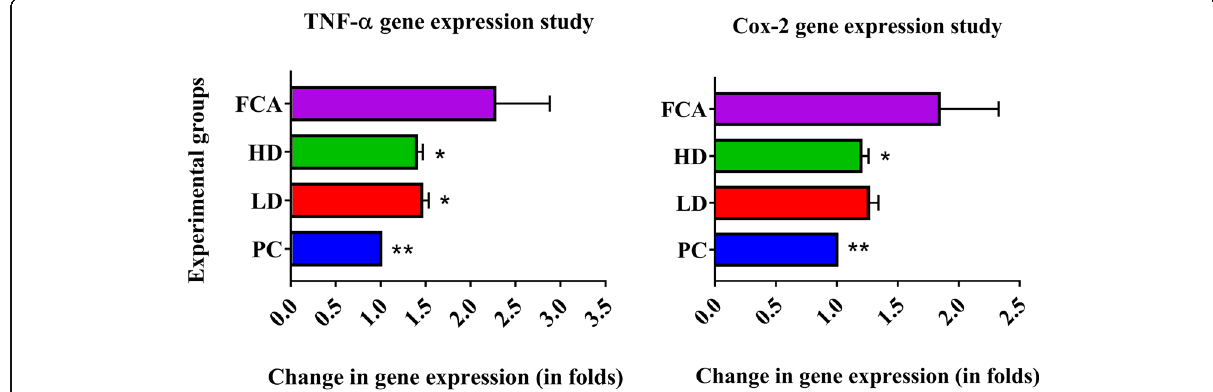
Fig. 3 Results of in vivo anti-inflammatory tests in graph. Relative expression fold changes in the TNF- α ( a ) and Cox-2 ( b ) genes assessed through reverse transcriptase real-time quantitative PCR. The significance value of low dose (LD) and high dose (HD) groups are compared with the experimental group (FCA). Positive control (PC). P value at P < 0.01 is considered